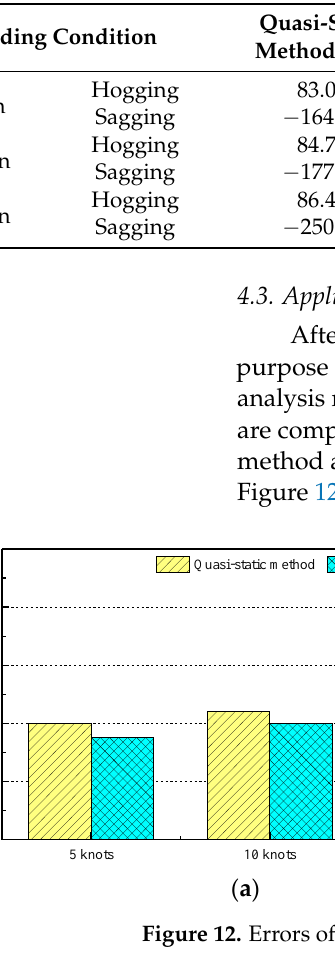
Table 6. Bending stresses from different methods (without slamming effect).